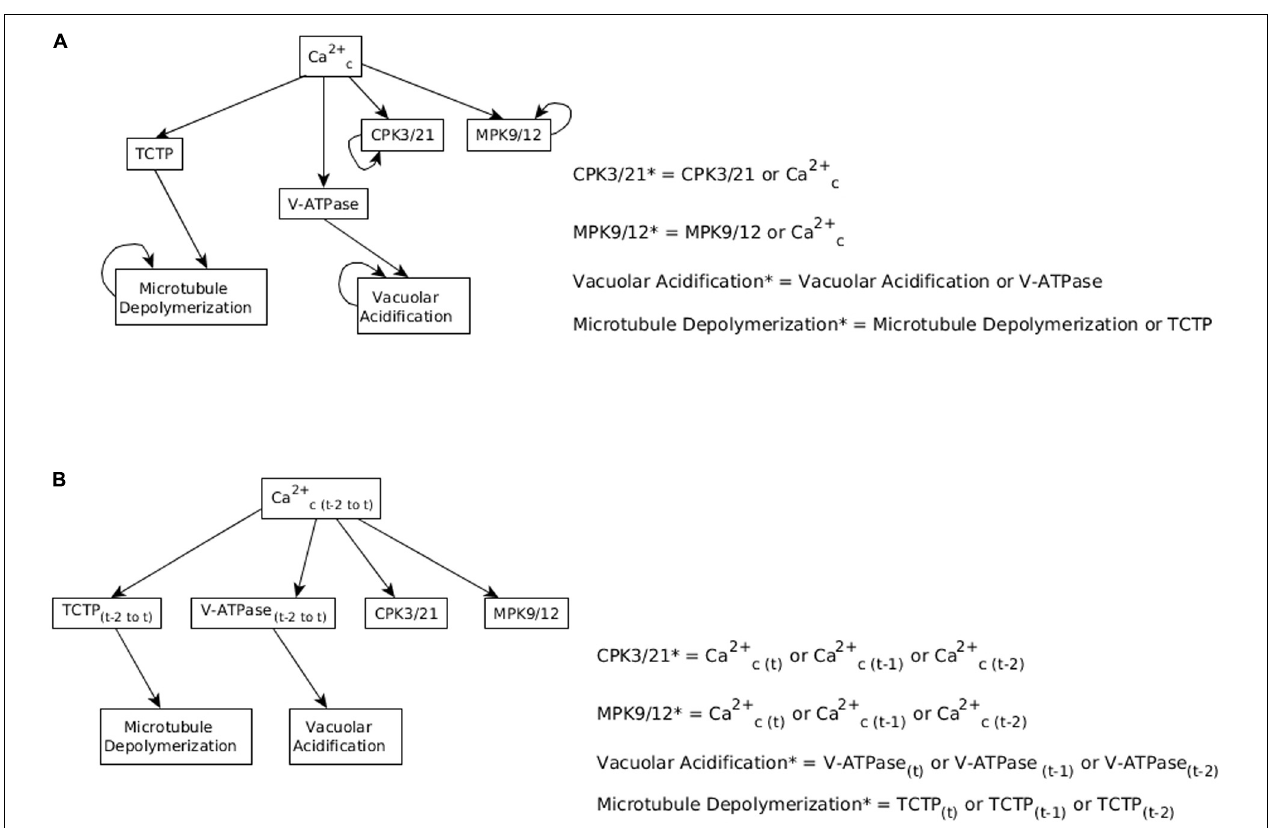
FIGURE 6 | Considering memory of the states of regulator nodes instead of persistent activity. (A) In Maheshwari et al. (2019), the nodes CPK3/21, MPK9/12, Vacuolar Acidification, and Microtubule Depolymerization have a persistence term in their update function to maintain them in a fixed ON state when Ca 2 + c oscillates. (B) Replacing persistent activity with short-term memory. The update function of each of the four nodes combines with an “OR” function the states of their respective regulator (Ca 2 + c , TCTP, or V-ATPase) at the current and previous two time-steps.